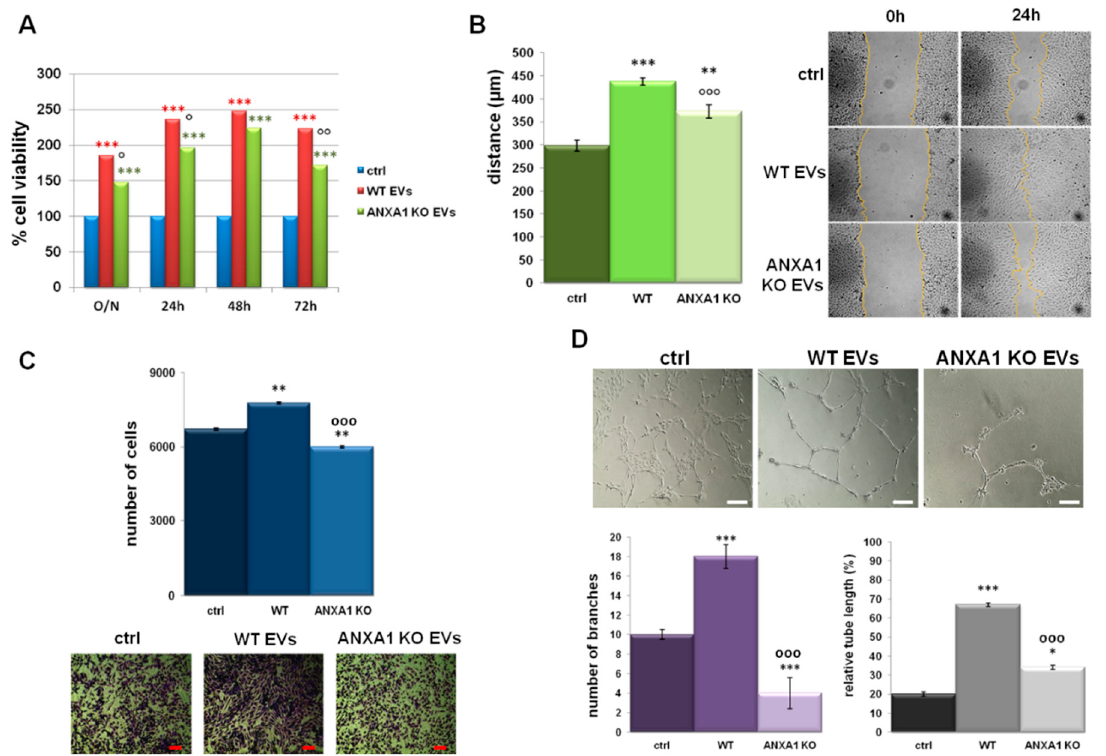
Figure 4. Effects of WT and ANXA1 KO MIA PaCa-2-derived EVs on HUVEC cells. ( A ) MTT (3-(4,5-Dimethylthiazol-2-yl)-2,5-Diphenyltetrazolium Bromide) assay on HUVEC evaluating cell viability. Results of Wound-Healing assay ( B ) and analysis of invasion speed with relative bright field images ( C ) of HUVEC cells treated or not with EVs from WT and ANXA1 KO MIA PaCa-2 cells. Bar = 50 µ m. ( D ) Representative images of tube formation by HUVEC cells seeded for 12 h on matrigel: EBM-2 1:1 and treated or not with EVs from WT and ANXA1 KO MIA PaCa-2 cells. Analysis of tube length and number of branches calculated by ImageJ (Angiogenesis Analyzer tool) software. Bar = 100 µ m. Data represent the mean of three independent experiments ± standard deviation with similar results, ◦ p < 0.05, *** (red and black asterisk) p < 0.001 treated cells vs untreated control and ◦◦◦ (circlets) p < 0.001 for HUVEC cells treated with ANXA1 KO MIA PaCa-2 EVs vs WT MIA PaCa-2 EVs.